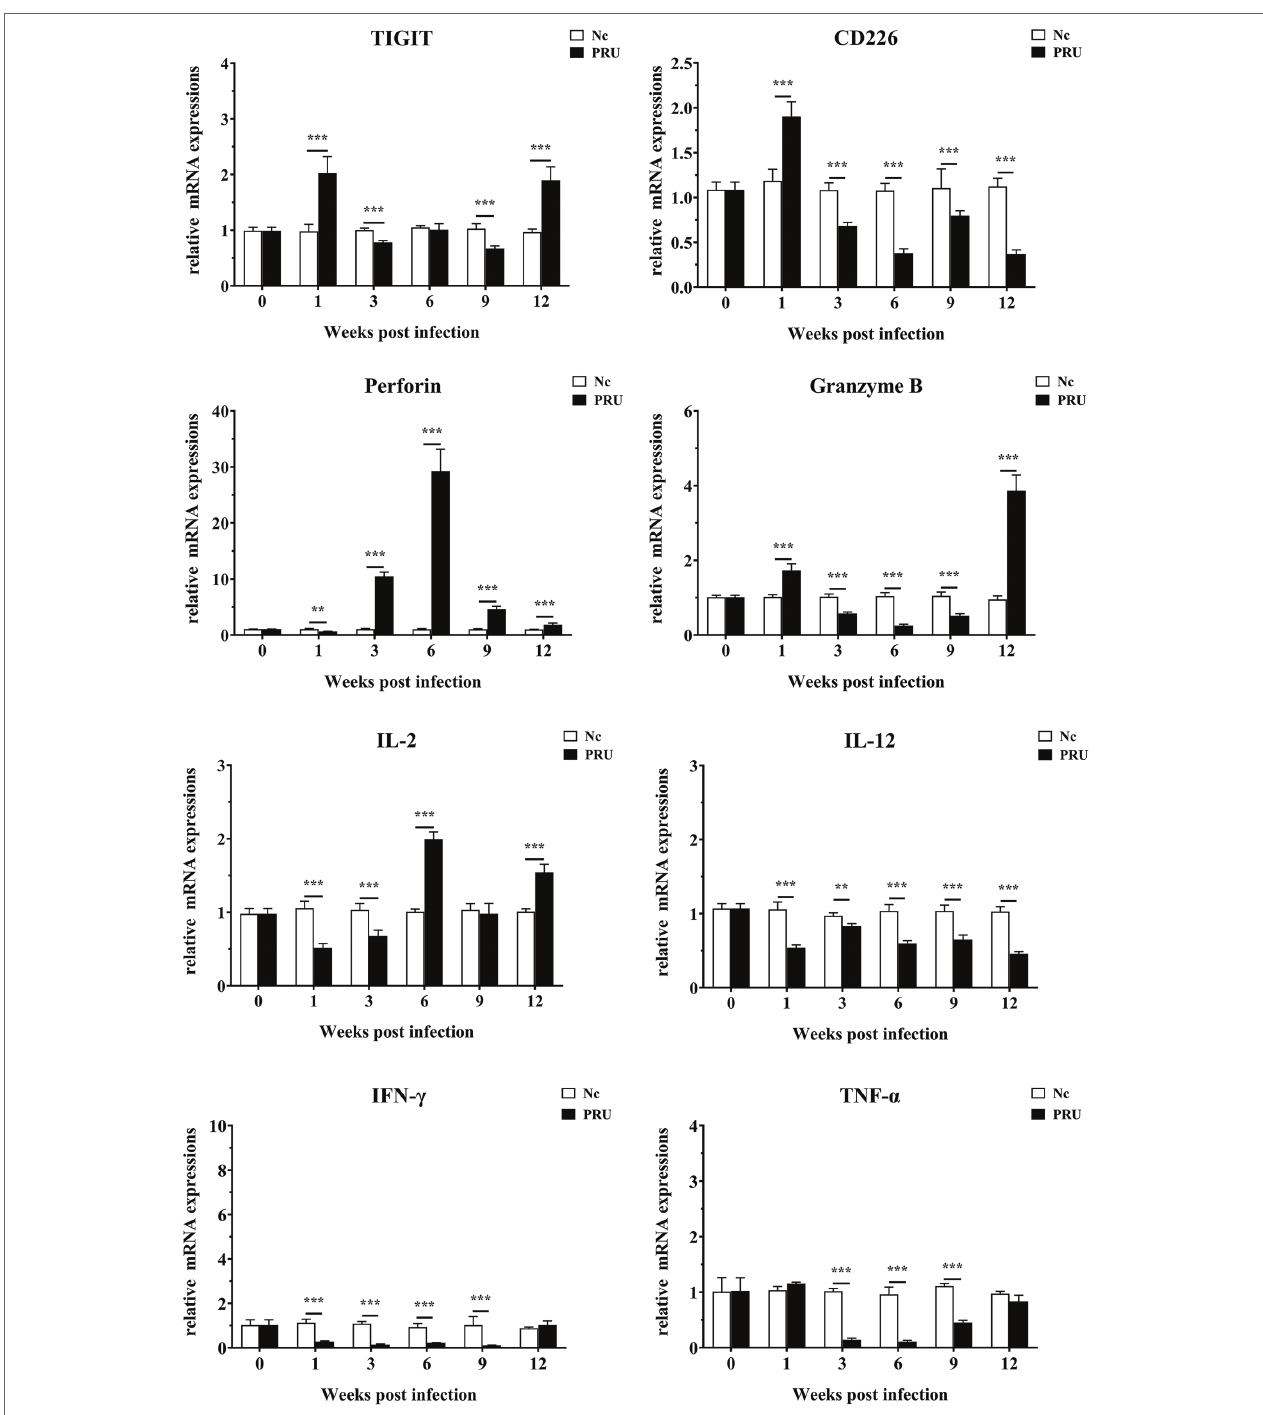
FIGURE 6 | mRNA expression of multiple transcripts in spleens from mice infected with the T. gondii PRU strain, as assessed by quantitative real-time PCR (qRT-PCR). Values are shown as the means of triplicate measurements, with data denoting means ± SDs; three independent experiments were performed with five mice per group. ** p < 0.01 and *** p < 0.001 (compared to the